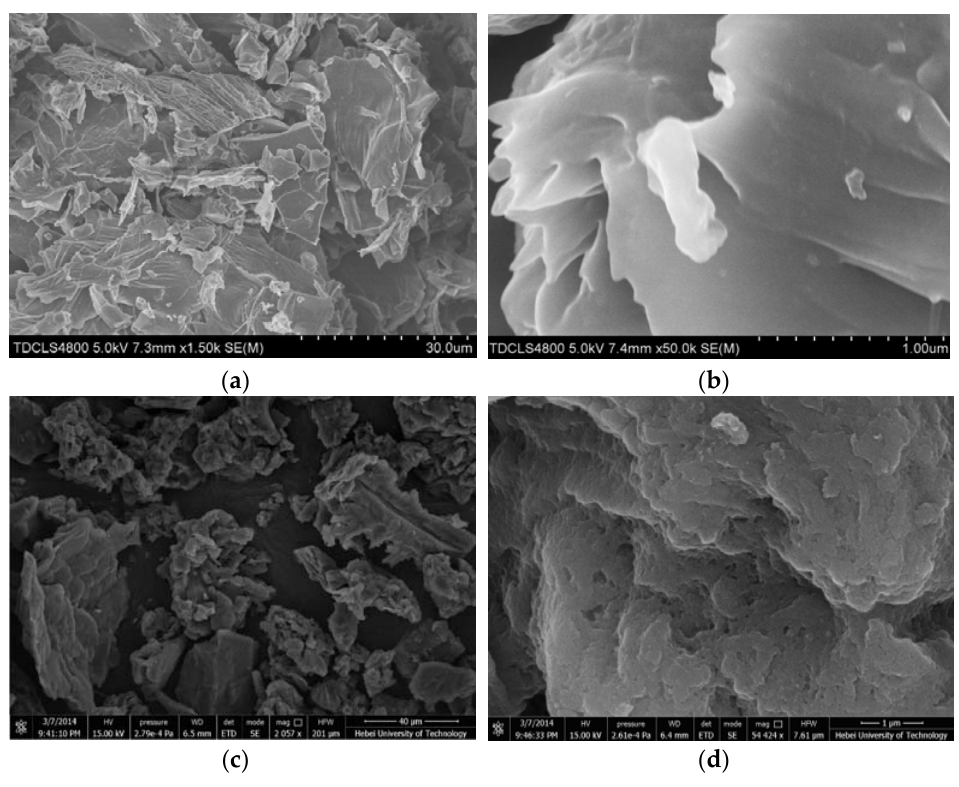
Figure 1. Scanning electron microscopy (SEM) images of CSA ( a , b ) and CSALA ( c , d ).